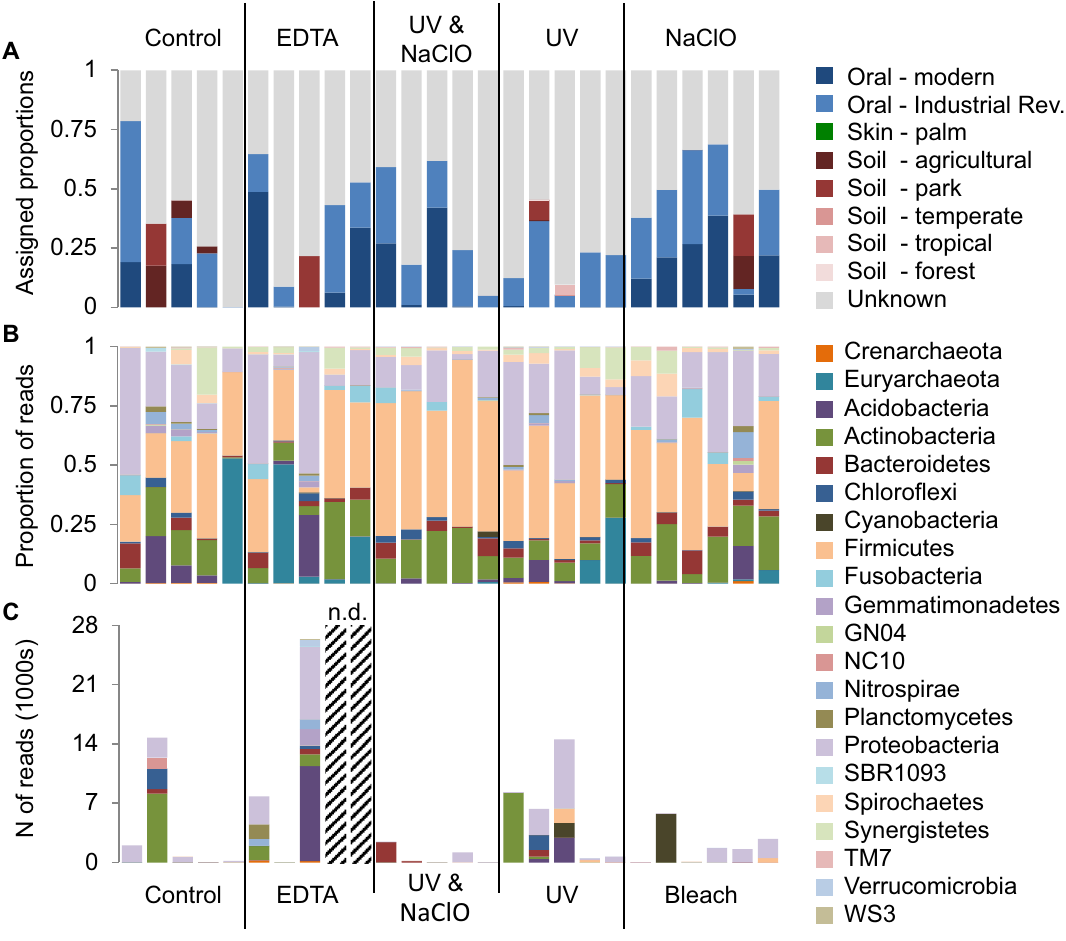
Figure 2. Contamination and taxonomic profiles of each sample based on 16S rRNA amplicon sequencing, grouped by decontamination protocol. The proportion of oral, skin, soil, and unknown OTUs in each sample. Proportions were defined by comparison to reference samples of oral, skin and soil microbial communities using the Bayesian modelling program SourceTracker ( A ). The OTUs identified within each phylum are displayed for each calculus sample (> 0.08% of total proportion) ( B ) and for each ethanol wash ( C ). These analyses used closed reference OTUs ( i.e. , OTUs identified in the GreenGenes